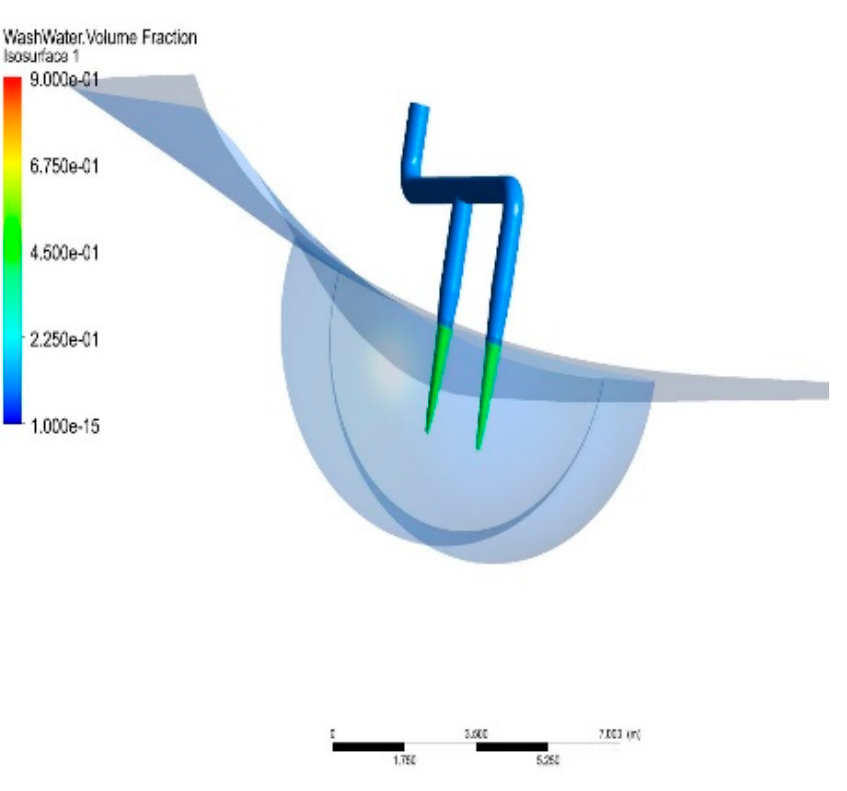
Figure 21. Scrubber Wash Water Volume Fraction of 0.44 isosurface development.